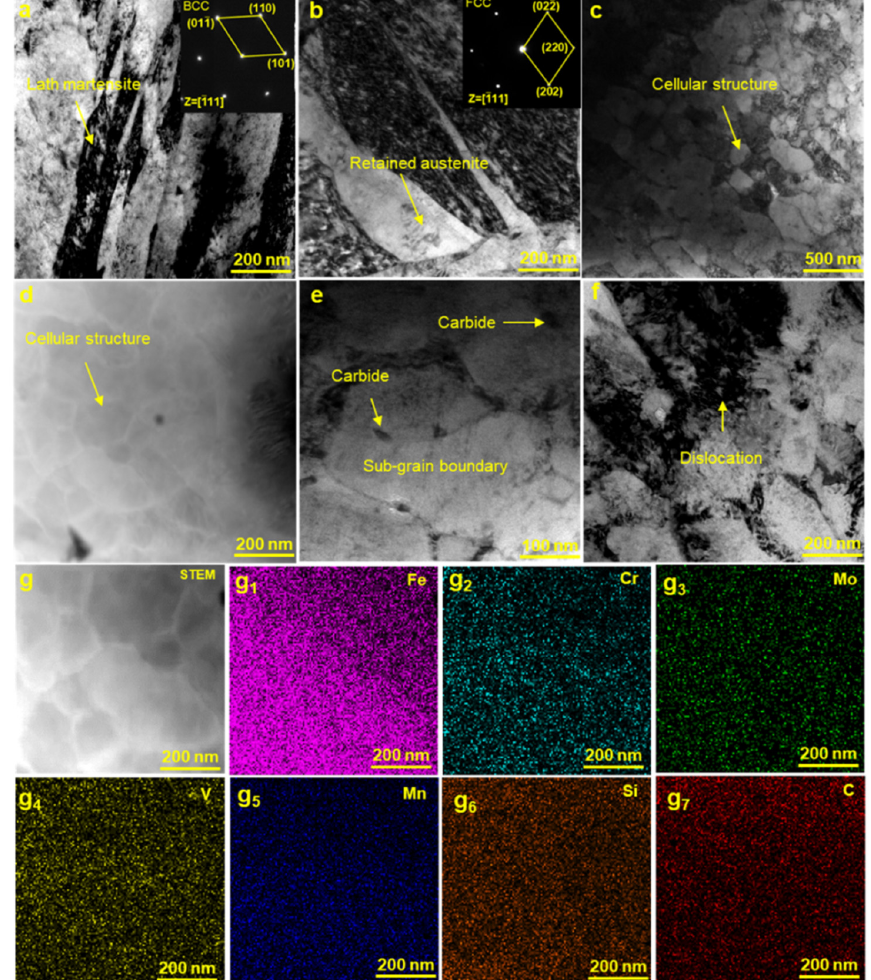
Figure 13. TEM micrographs of the as-SLMed H13 steel specimens, showing ( a ) bcc-structured lath martensite; ( b ) the formation of retained austenite with high cooling rate; ( c ) cellular structure; ( d ) STEM image of the cellular structure shown in ( c ); ( e ) carbides at and within sub-grain boundaries; ( f ) the density of dislocations; (g, g1-g7) the corresponding EDS maps of cellular structure, including elements of (g1) Fe, (g2) Cr, (g3) Mo, (g4) V, (g5) Mn, (g6) Si and (g7) C.